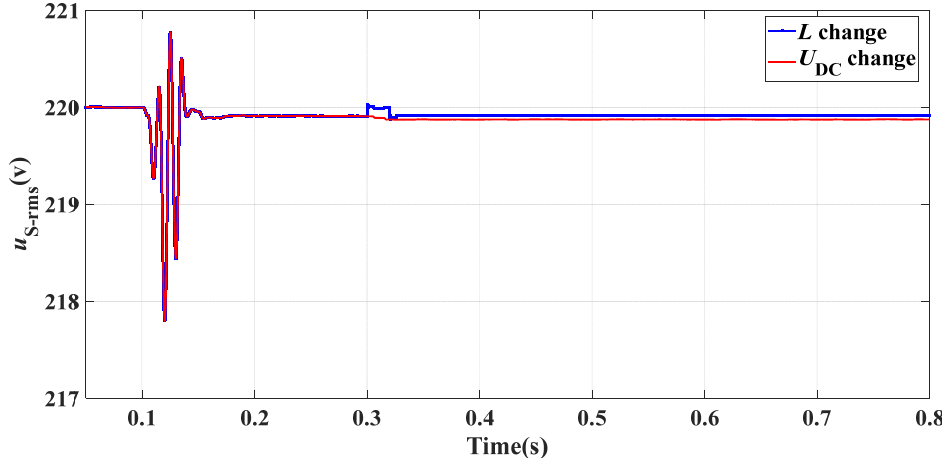
Figure 11. Anti-interference ability of the ASMC strategy when u inm_sw uses a saturation function.